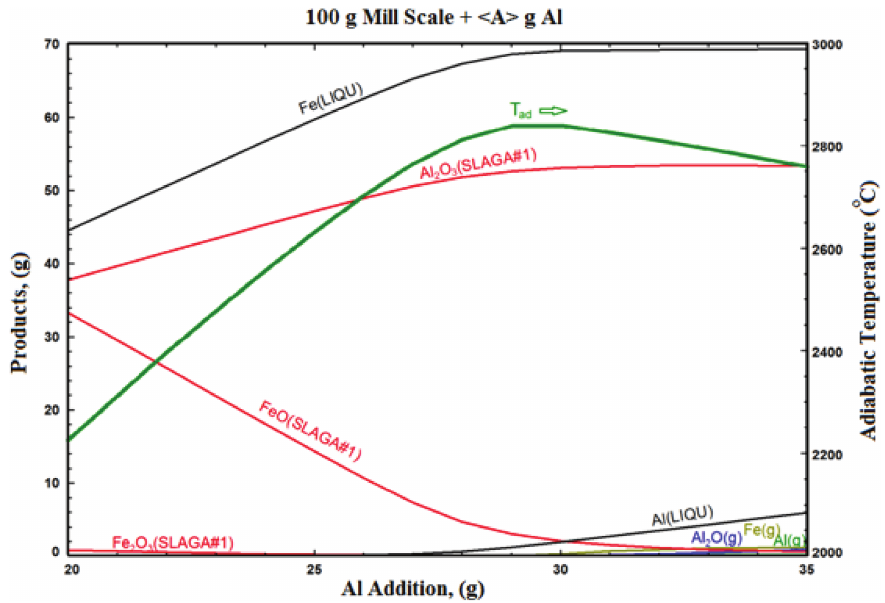
Figure 2: The change of adiabatic temperature with the increase in Al reductant amount on mill scale - Al reactant system.